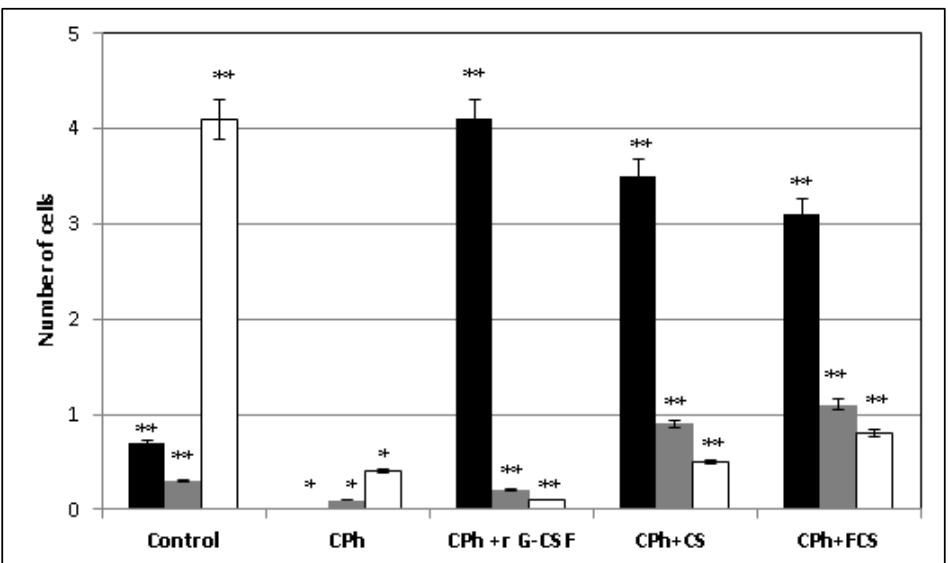
Figure 3. Different populations of leucocytes (WBCs) in blood of mice with CPh-induced immunosuppression after treatment with recombinant granulocyte colony-stimulating factor (r G-CSF), chondroitin sulfate ( CS ) and fucosylated chondroitin sulfate ( FCS ) (mean ± SD). Neutrophils × 10 6 /mL, ■ monocytes × 10 6 /mL, □ lymphocytes × 10 6 /mL. * p < 0.05 vs. control, ** p < 0.05 vs. CPh.